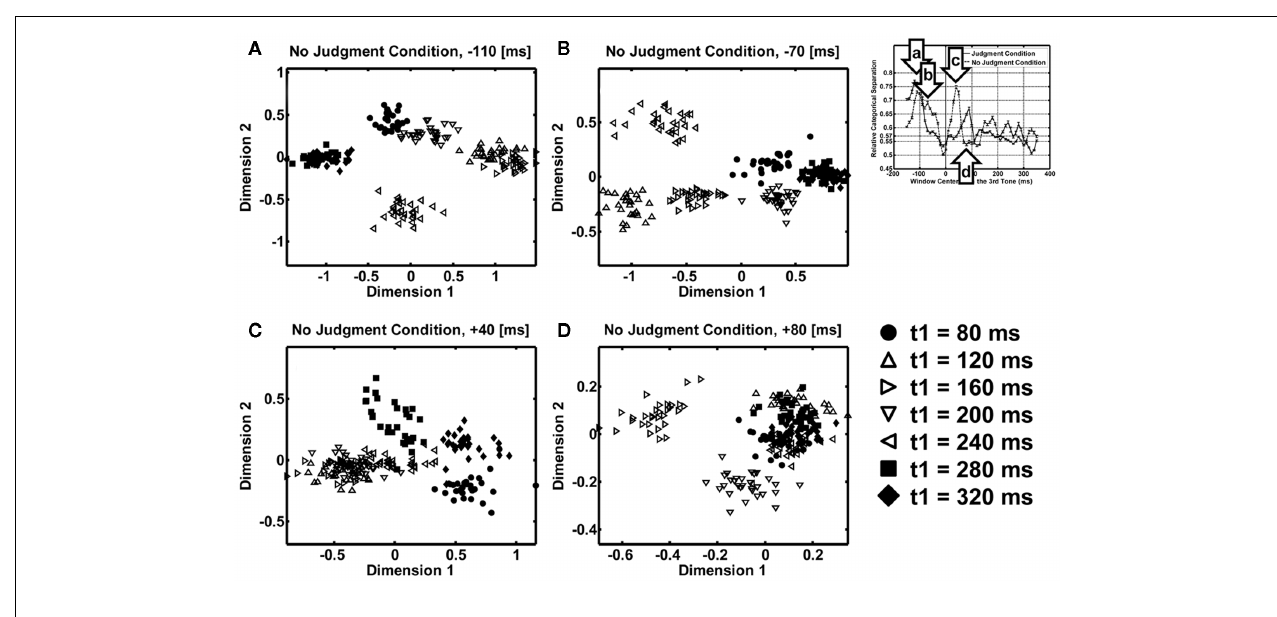
after the third tone – at the valley of the relative categorical separation. Filled symbols represent perceptually unequal temporal patterns. Open symbols represent perceptually equal temporal patterns.The scatter of a symbol shows the variability across different resampling in bootstrapping ( N =